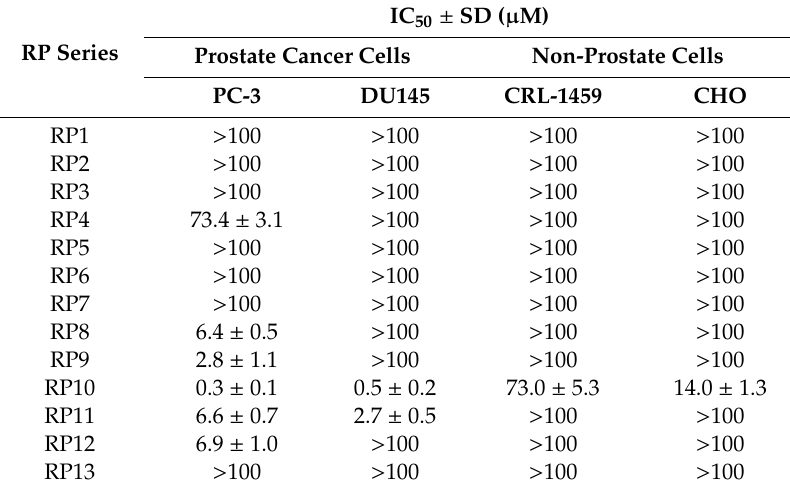
Table 1. Cytotoxicity data for the RP-010 series compounds (RP-01–RP-013) on prostate cancer (PC) vs. non-PC cell